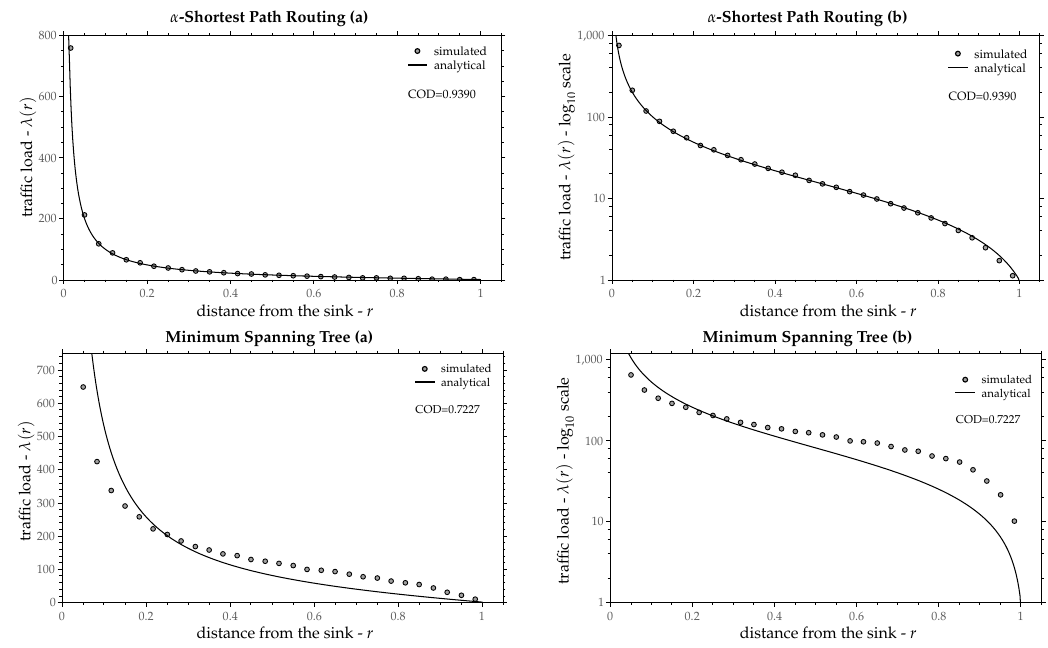
Figure 13. Comparison between Equation (25) and the simulated traffic load as a function of the distance from the sink, for two routing schemes, α -Shortest Path and Minimum Spanning Tree. ( a ) normal (linear) plot, ( b ) semi-log plot (log-linear). Greedy Geographical Routing (a)